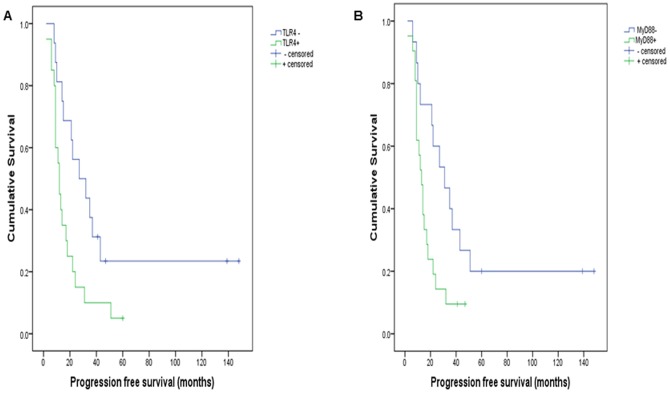
TLR4/MyD88 and progression-free survival (Kaplan-Meier curves; median survival shown in months).TLR4 (A) or MyD88 (B) negative cases had significantly better PFS (15 & 18 months longer; p<0.05).